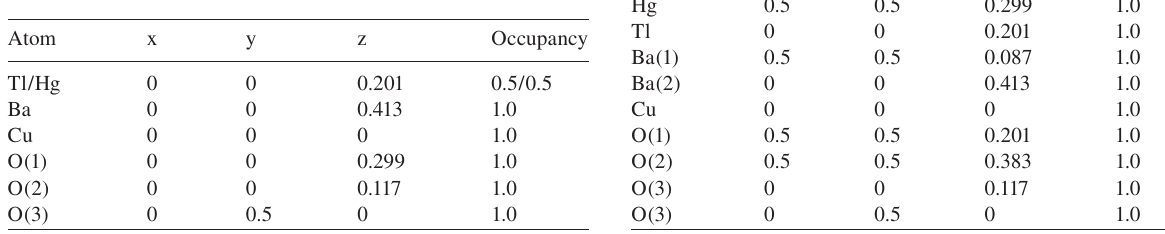
Figure 8 (A) HREM image of HgTlBa CuO and (C) HgTlBa HgTlBa 2 6 R